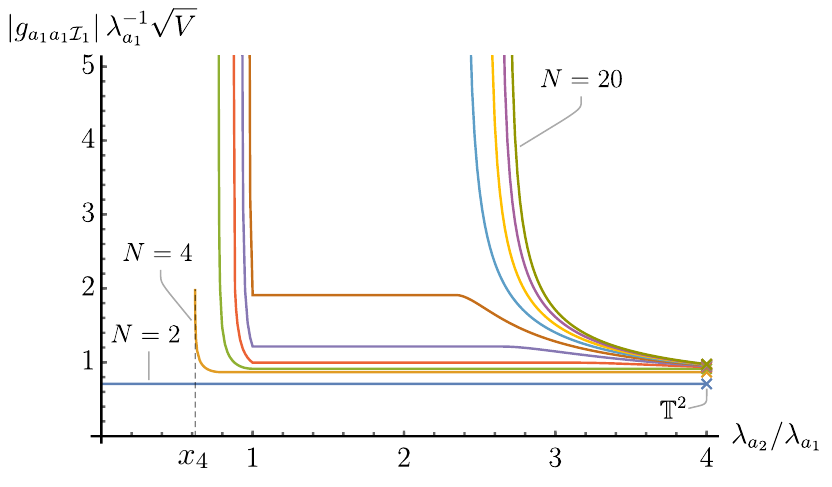
=(cid:21) a for closed Einstein manifolds 2 1 = 0, where (cid:21) a 2 1